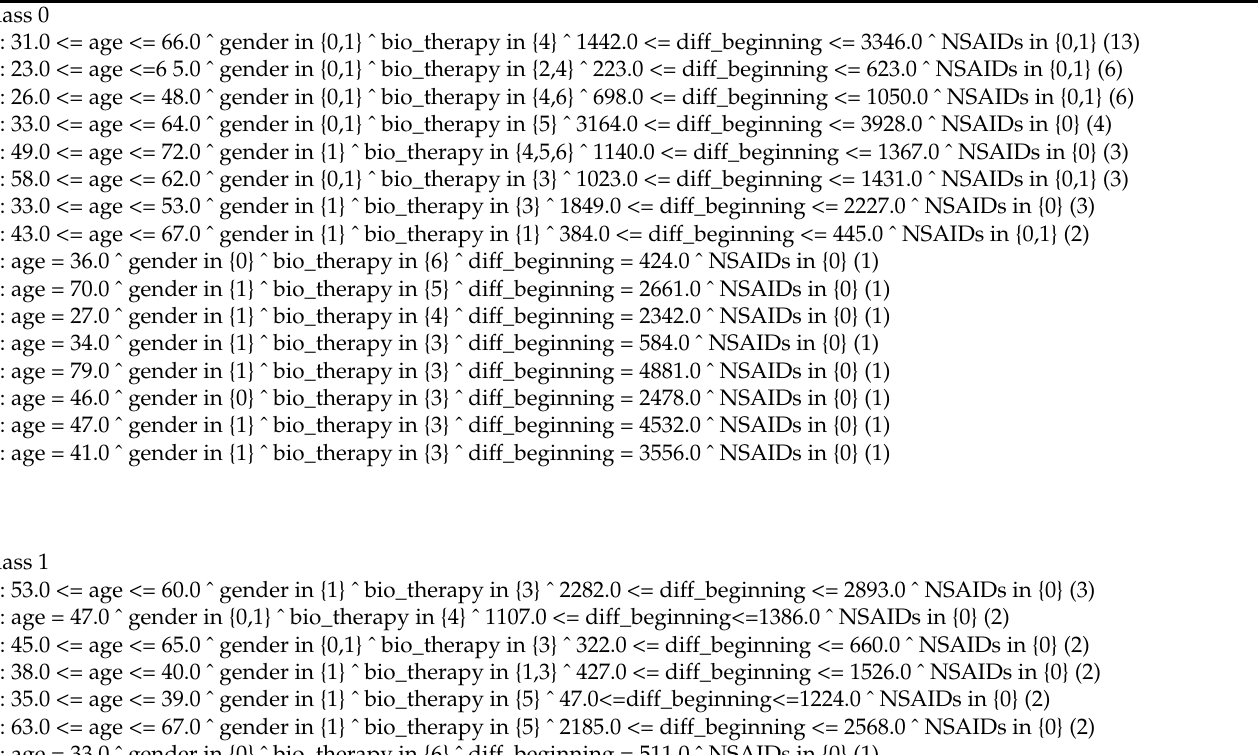
Table 18. Example of rules for QuantiFERON prediction, obtained with the NNGE algorithm.